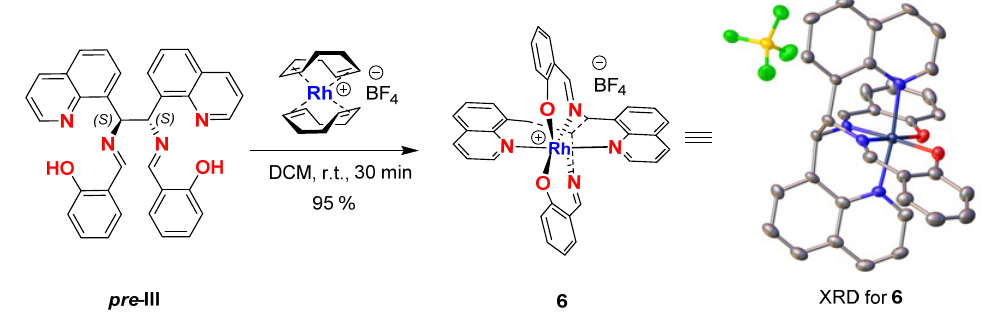
Figure 3. The synthesis and crystal structure obtained from the XRD analysis of Rh (III) complex 6